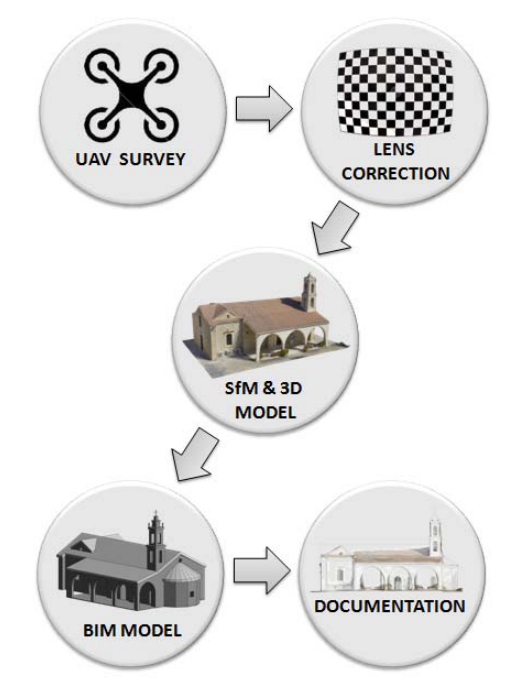
Figure 3. Methodology